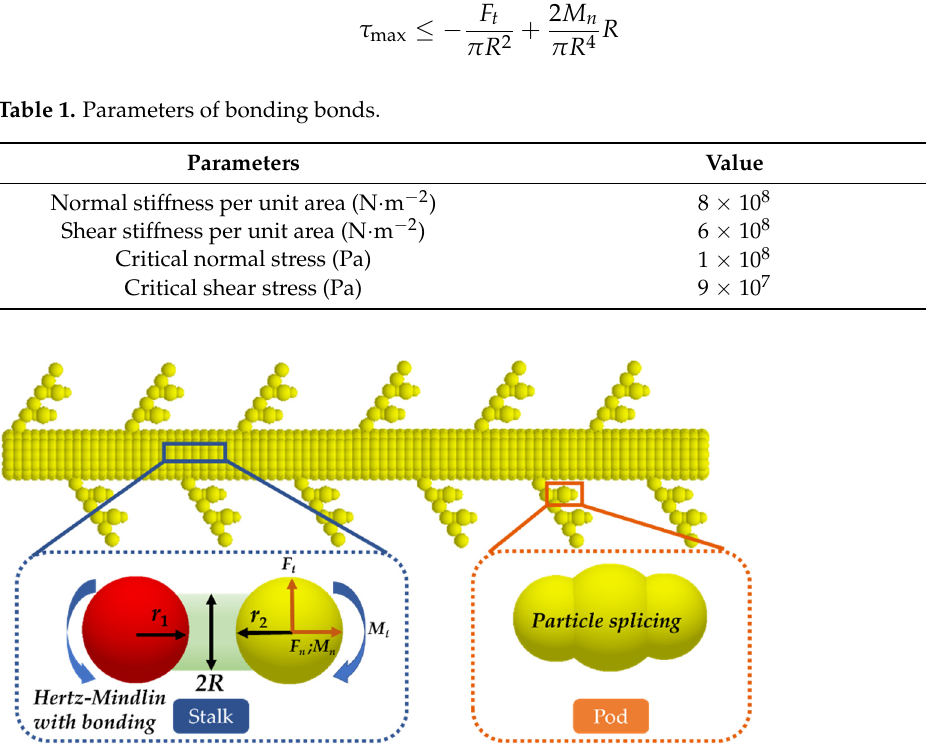
Table 3. Characteristics parameters of oilseed rape plant.